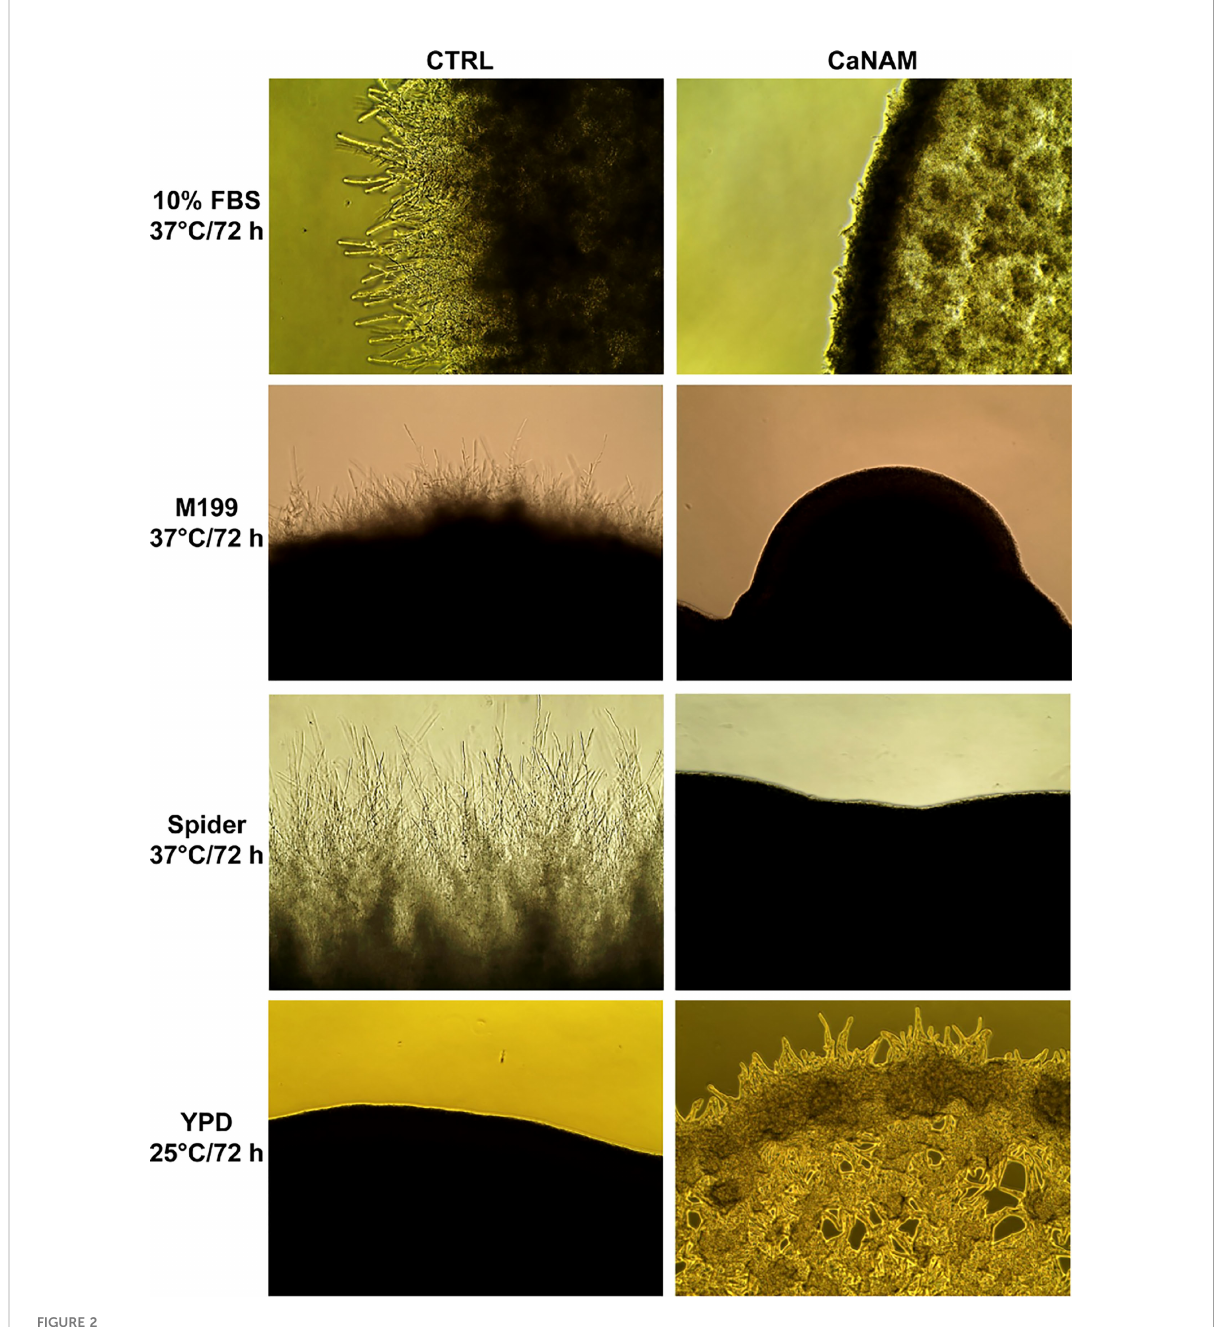
FIGURE 2 Colony morphologies of C. albicans grown on different media with or without 25 mM NAM. C. albicans was grown in the indicated media, w/ wo NAM, for 72 h, and the morphology was examined by optical microscopy at 10X magni fi cation. The addition of 25 mM NAM inhibits the fi lamentation in hyphae-inducing conditions (10% FBS, M199 or Spider Medium; 37°C), whereas in the yeast-promoting condition (YPD; 25°C), the treatment with NAM triggers the formation of abnormal and enlarged fi lamentous structures called V-shaped